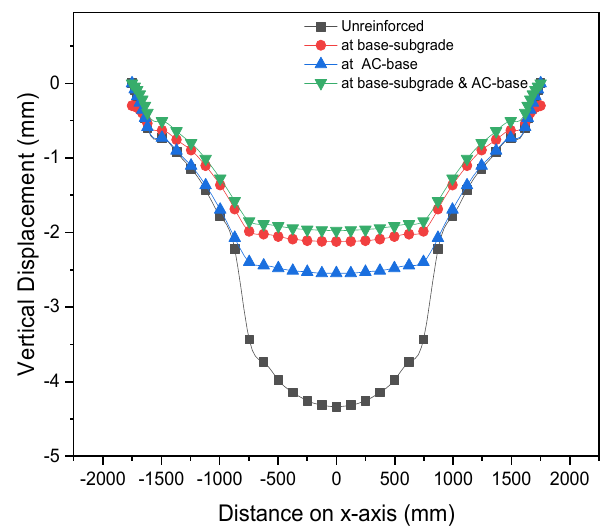
Figure 4. Comparison of vertical displacement on top of the subgrade.